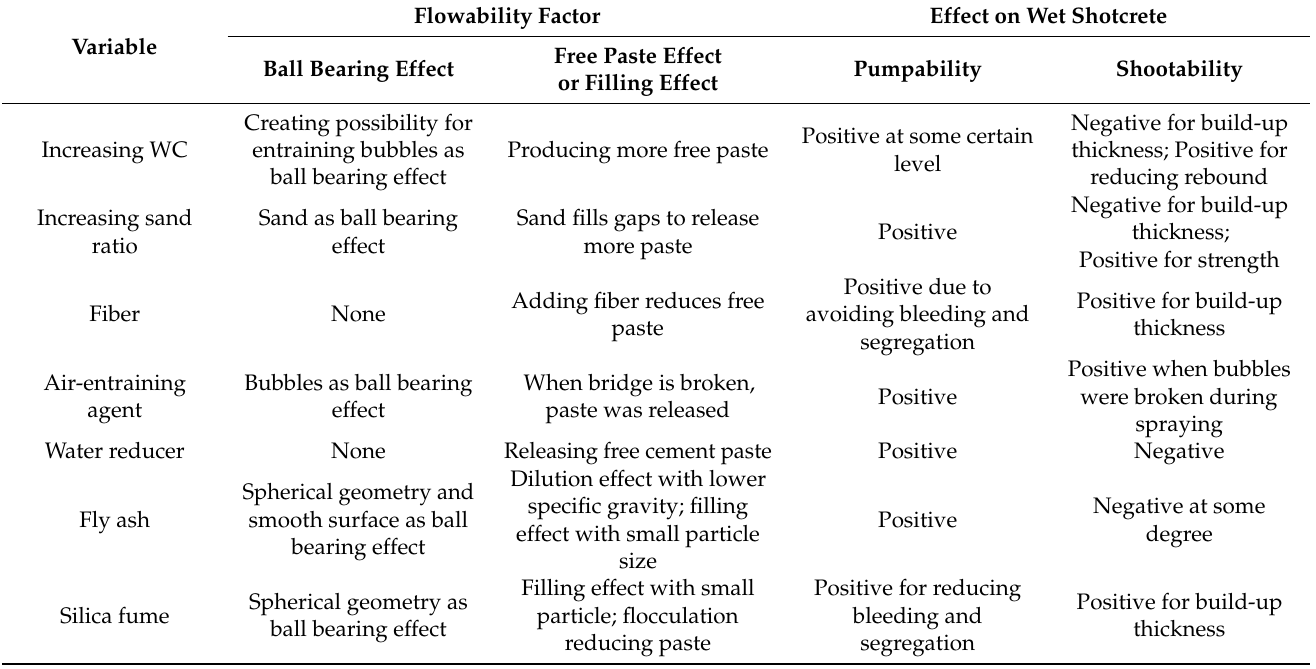
Table 4. Summary of various factors affecting shotcrete in pumpability and shootability.